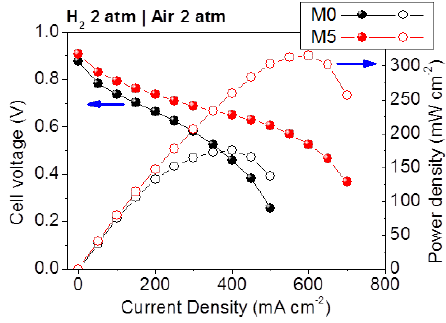
Figure 10. Fuel cell performances under 30% RH and 110 °C. H 2 -Air fed at 2 atm. In operating conditions of 70 °C and RH = 30% the performances of the cell adopting M5 membrane compare well to those of M0. As expected, at higher temperature and such low RH (30%) the overall performances of both cells decline. However the M5 cell outperforms plain recast Nafion™ at 110 °C. The different performances can be demonstrated comparing power and current values delivered by each cell: at 70 °C there are only slightly differences in maximum power (between 350 mW/cm 2 and 400 mW/cm 2 ), with no valuable difference in the current values; on the contrary, at 110 °C and 30% RH , the cell based on M5 shows strong increase in performances with respect to M0, both in maximum power (300 mW/cm 2 for M5 and 150 mW/cm 2 for M0) and current delivered at maximum power (600 mA/cm 2 for M5 and 400 mA/cm 2 for M0). Impedance spectra measured at 6.5 V for both fuel cells under 70 °C and 110 °C and 30% RH are shown in Figure 11. The higher frequency intercepts on the real axis can be considered as the total non-electrode ohmic resistance of the cell, meanwhile the lower frequency intercepts is due to the overall charge transfer interfacial resistances. The composite M5 membrane shows smaller ohmic resistance both at 70 °C and 110 °C as well as smaller charge transfer resistance compared to M0. These enhanced electrode/electrolyte interfacial properties, as well as the lower ohmic resistance associated with M5, explain its better behavior showed above in terms of cell performance. Since the thickness of the two membranes is comparable (see data shown in Table 1) and electrode active area is the same, the reduction of the ohmic resistance can be easily attributed to the larger conductivity value observed for the M5 membrane compared to Nafion™ at low humidity ( RH = 30%). Turning to the different charge transfer resistance, one may speculate about a possible improved interfacial properties between membrane and electrode in the presence of the S-TiO 2 filler. In literature the beneficial effect of inorganic additives on the relaxation process of Nafion™ at high temperature and